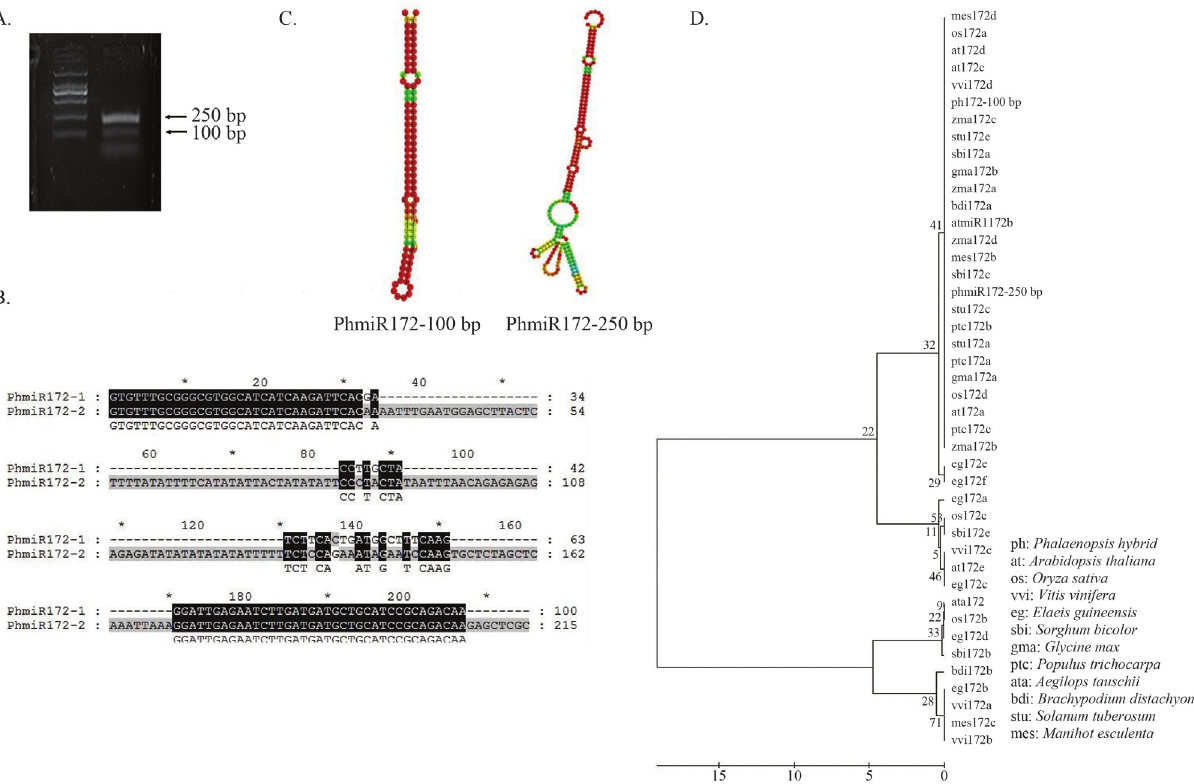
Figure 2 - Cloning and sequence analysis of Phalaenopsis miR172s. (A) PCR amplification of novel PhmiR172 sequences. (B) Sequence alignment of PhmiR172-1 and PhmiR172-2. Dark regions represent identical nucleotides. The primer sequences are indicated under the alignment. *Conserved nucleo- tides. (C) Secondary structures of precursor PhmiR172s, both with unique stem-loop structures. The red color indicated the higher possibility of base-pairing.When the color is inclined to be red, the possibility of base-paring is becoming higher. (D) Phylogenetic tree of miR172 precursors from Arabidopsis , Oryza and Phalaenopsis constructed using the maximum evolution method. The horizontal scale at the bottom was the scale for substitution rate (%). The numbers at the nodes refer to the bootstrap value (maximum is 100), which implied the reliability of existing clades in the tree. The number in eachcladerepresentedthepercentageofsuccessforconstructingtheexistingclade.Thesystemhasperformed1000replicatestoconstructthephylogeny.